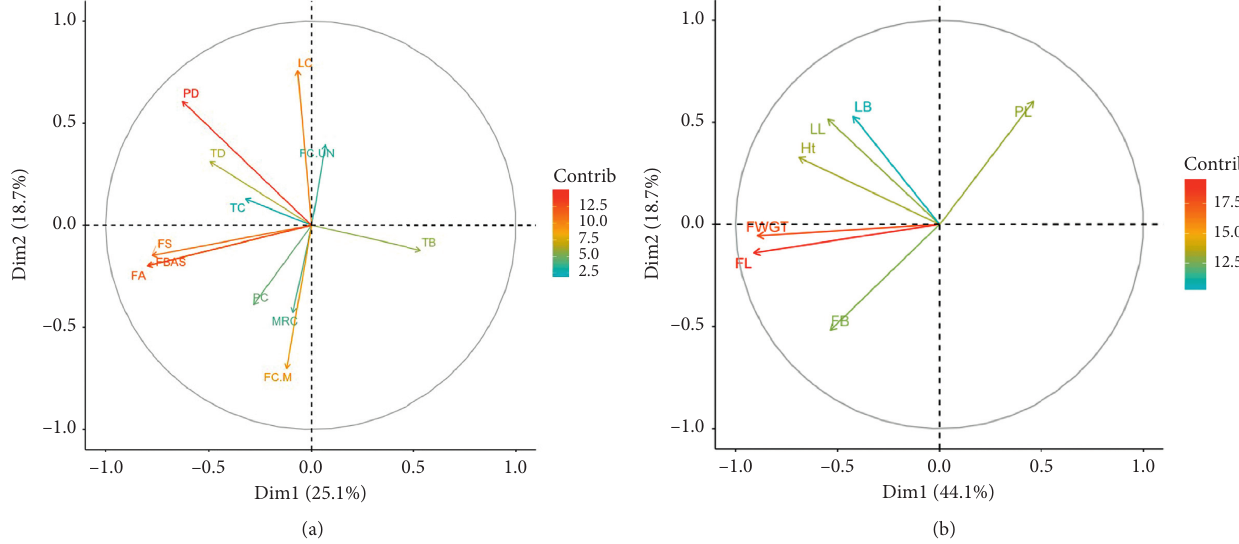
Figure 6: Variables’ PCA plot of quantitative and qualitative traits of H. compressa in Kenya. (a). Variable PCA plot of qualitative traits.